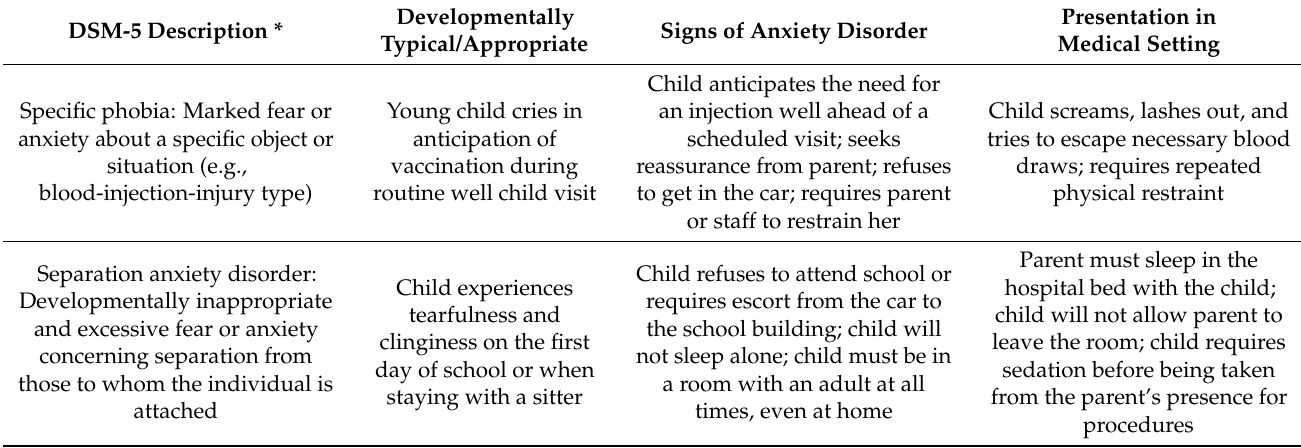
Table 1. Examples of anxiety-related symptoms exhibited in a medical